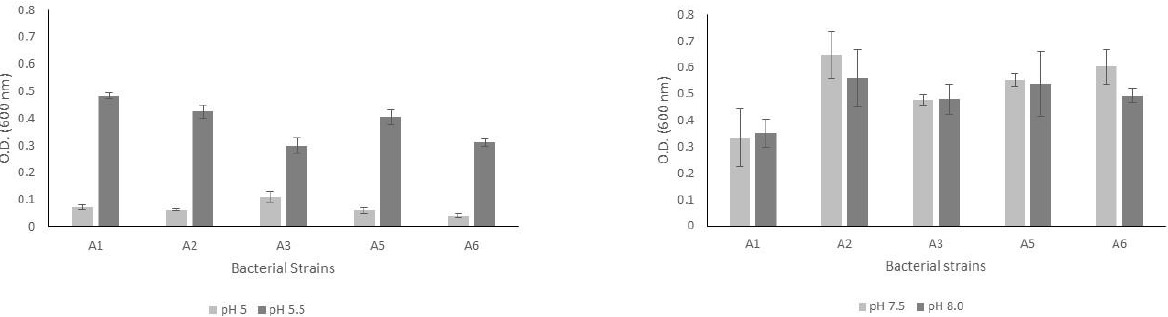
Figure 1. Results of bacterial growth measured by optical density for the five bacterial strains cul- tured in PVK medium in both acidic (left graph) and alkaline (right graph) pH ranges.